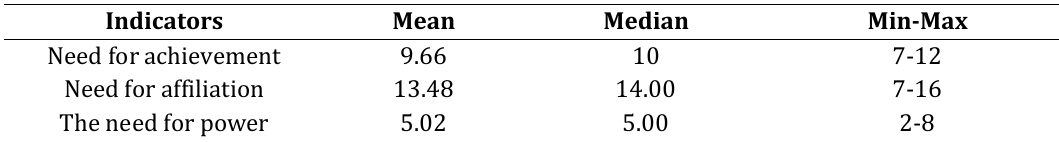
Dimension of Motivation among Professional Nurse Professional Study Program Students in Jember District (n =